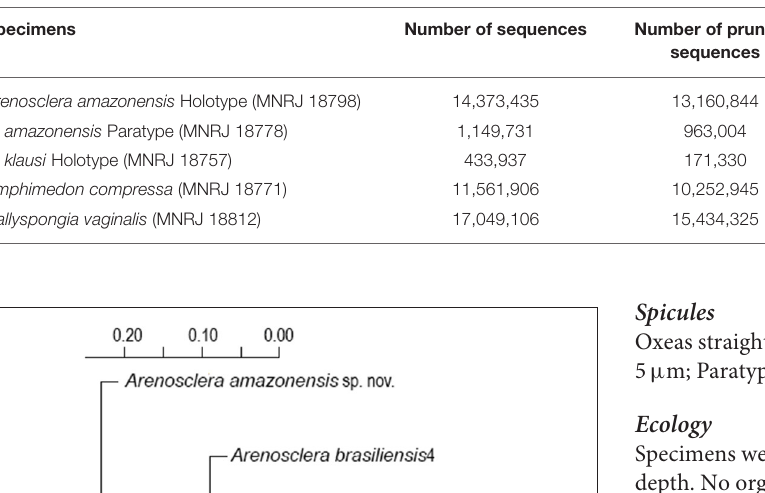
TABLE 3 | HiSeq (Illumina, USA) results.